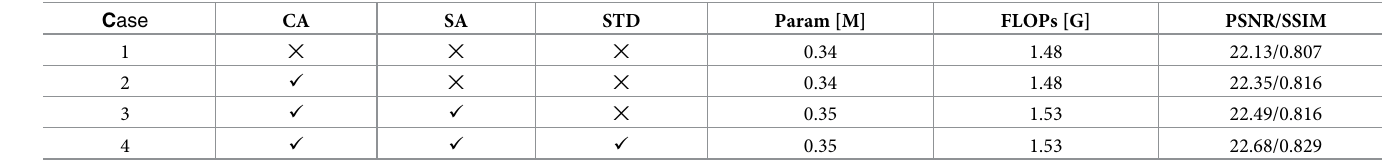
Table 6. Study on Dual Attention Block (DAB). CA,SA,STD are channel attention, spatial attention, and standard deviation respectively.